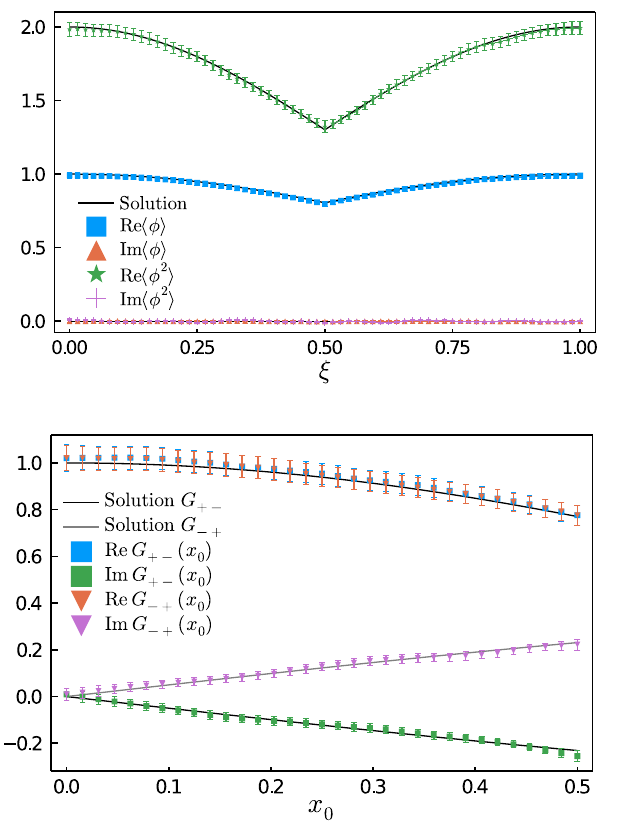
Figure 8 . (Top) The field expectation value h φ i (box and triangle), as well as the equal-time correlation function h φ 2 i (filled star and cross) evaluated out-of equilibrium for a Gaussian density matrix, along the whole simulation contour, parametrized by ξ . The continuous Langevin time solution from matrix mechanics is given as solid line. (bottom) The phenomenologically relevant non-equilibrium forward G + − = G > and backward G − + = G < correlation